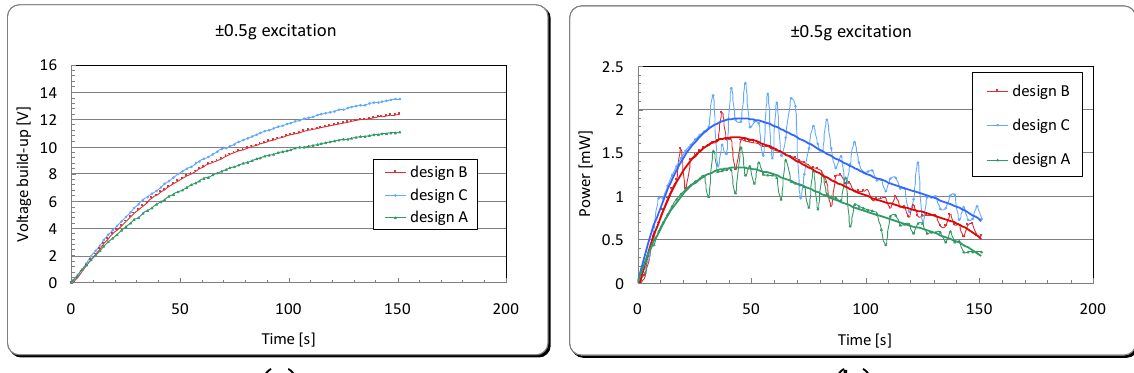
Figure 21. ( a ) Voltage build-up in a 2,200 μF capacitor and ( b ) the corresponding generated power by the energy harvester under ±0.5 g acceleration of